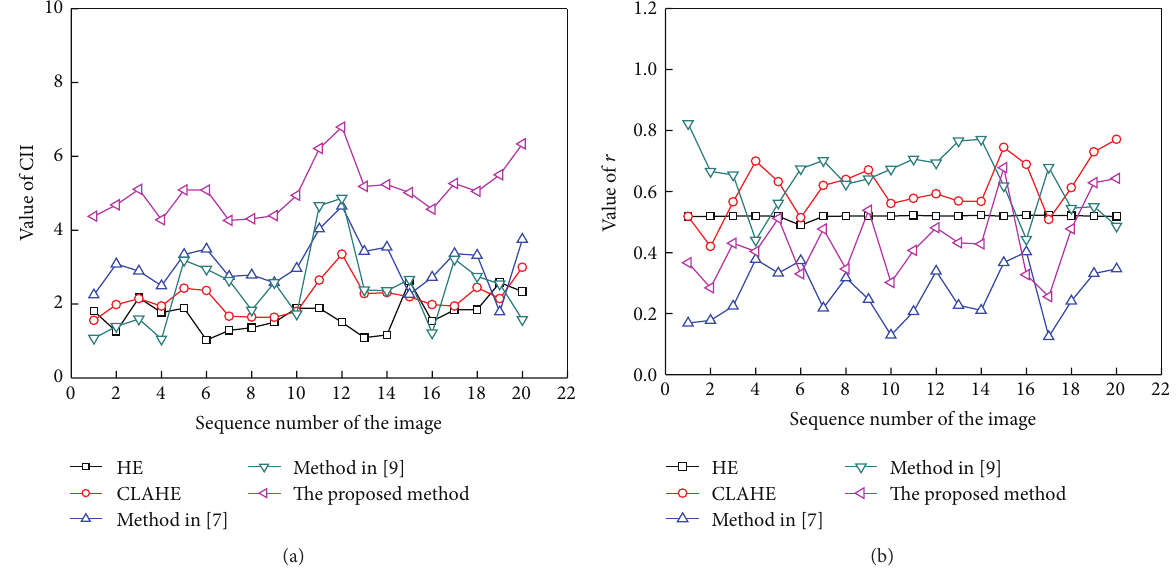
Figure 11: Comparison of the line charts of CII and 𝑟 on the STARE database. (a) The line charts of CII; (b) the line charts of 𝑟 . Table 4: The average running time comparison of different methods on the DRIVE database (including 40 images). Evaluation methods